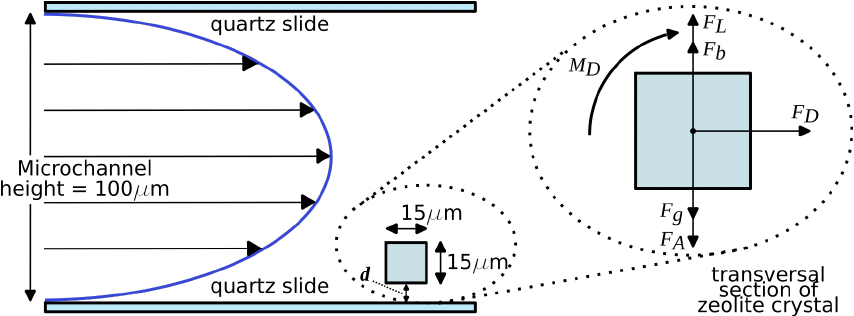
Figure 5. Forces acting on a zeolite crystal in a parabolic velocity